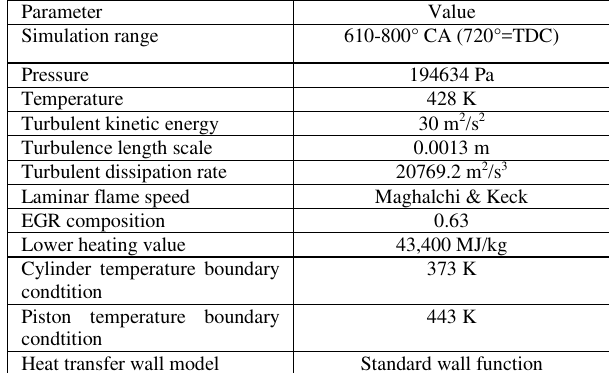
Table 2. Simulation parameters and initial conditions